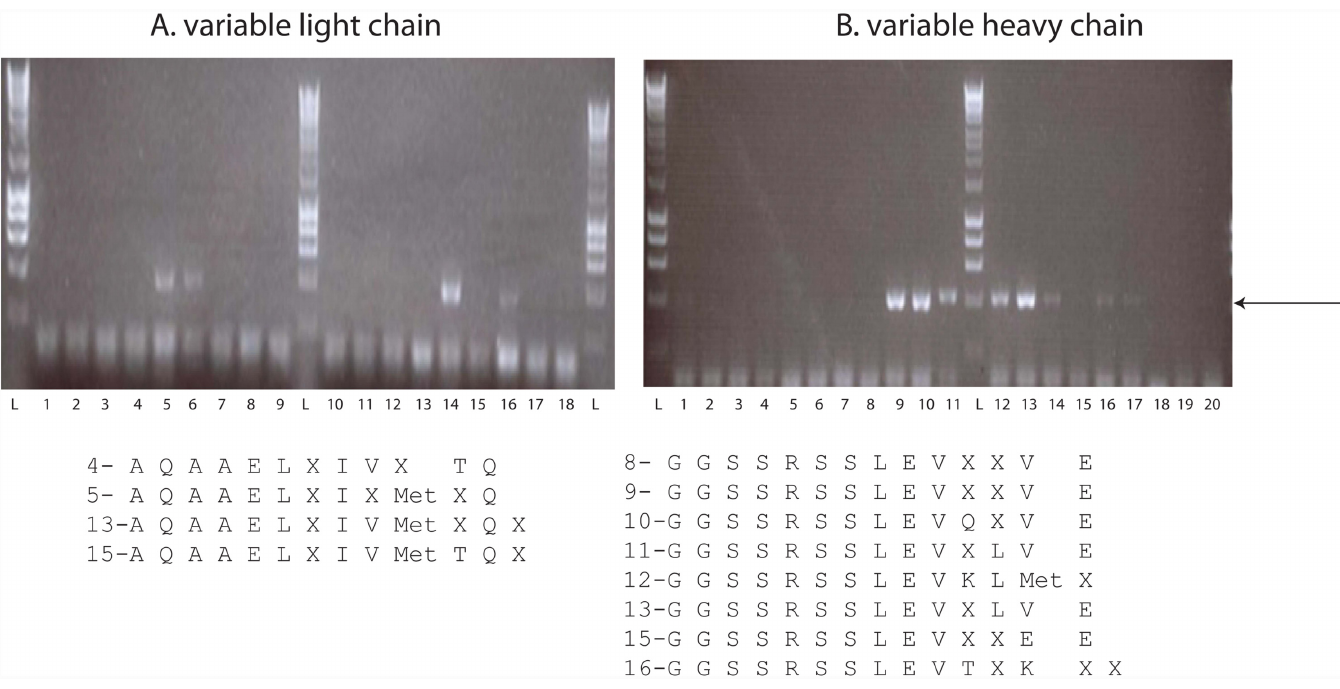
Fig 7. Amplification of heavy and light chains using PCR primer sets. RNA was isolated from NCD1.2 hybridoma cells and PCR amplified products (using the numbered oligonucleotide primers sets below each fig (decoded in the materials and methods) from cDNA were isolated on a 1.5% agarose gel: (A). Variable light chain amplification with 5 ’ sense and 3 ’ reverse primer sets: Lane L, ladder; Lane 1, negative control; Lanes 2 – 9, incorporate 5 ’ primers MSCVK1-MSCVK8; lanes 10 – 18 incorporate 5 ’ primers MSCVK9-MSCVK17. The 3 ’ primer reverse sets in each reaction were MSCJK12-BL, MSCJK4-BL, and MSCJK5-BL. (B). Variable heavy chain amplification with 5 ’ sense and 3 ’ reverse primer sets: Lane L, ladder; Lane 1, negative control; Lanes 2 – 11, incorporate 5 ’ primers MSCVH1-MSCVH10 and lanes 12 – 20 incorporate 5 ’ primers MSCVH11-MSCVH19. The 3 ’ primer reverse sets in each reaction were MSCM-B MSCG3-B MSCG1ab-B. The arrow highlights the position of the variable heavy or light gene. The amino acids sequences below each gel (from primers 4, 5, 13, and 15 for the light chain and primers 8, 9 – 13, 15, and 16 for the heavy chain) highlight the possible sequences of the framework regions to be expected in the sequences of the isolated, bioactive